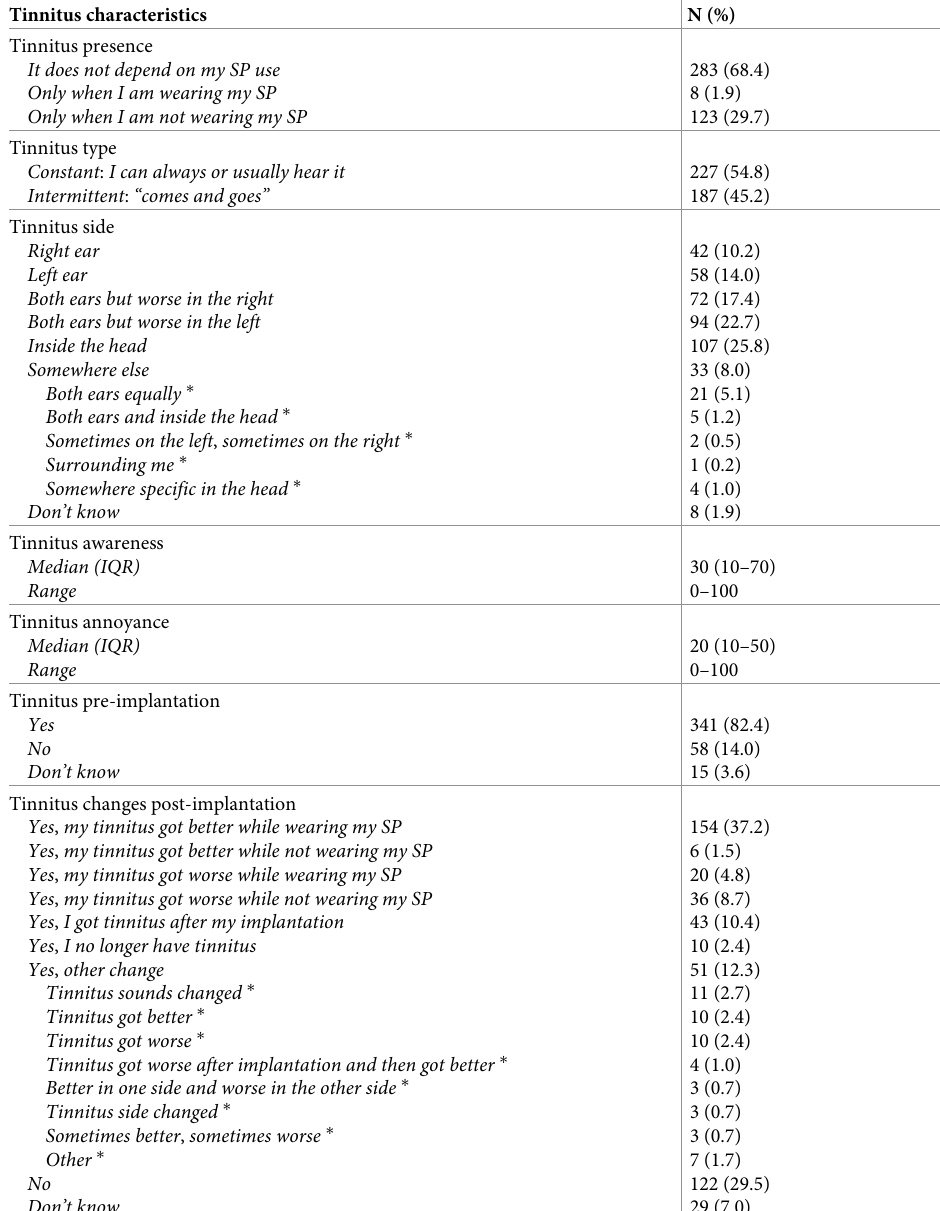
Table 2. Tinnitus characteristics. Tinnitus